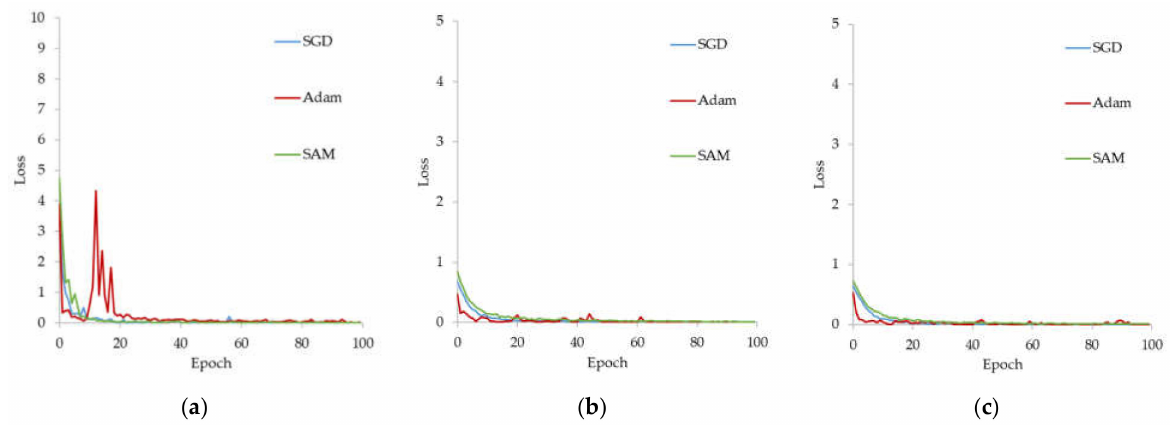
Figure 15. Training losses of CNN classifiers on the USD dataset with various optimization methods: